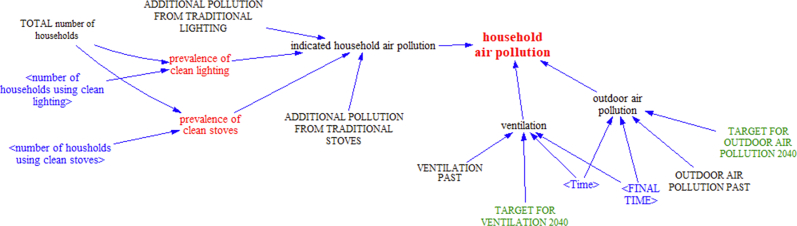
Formulation of household air pollution.